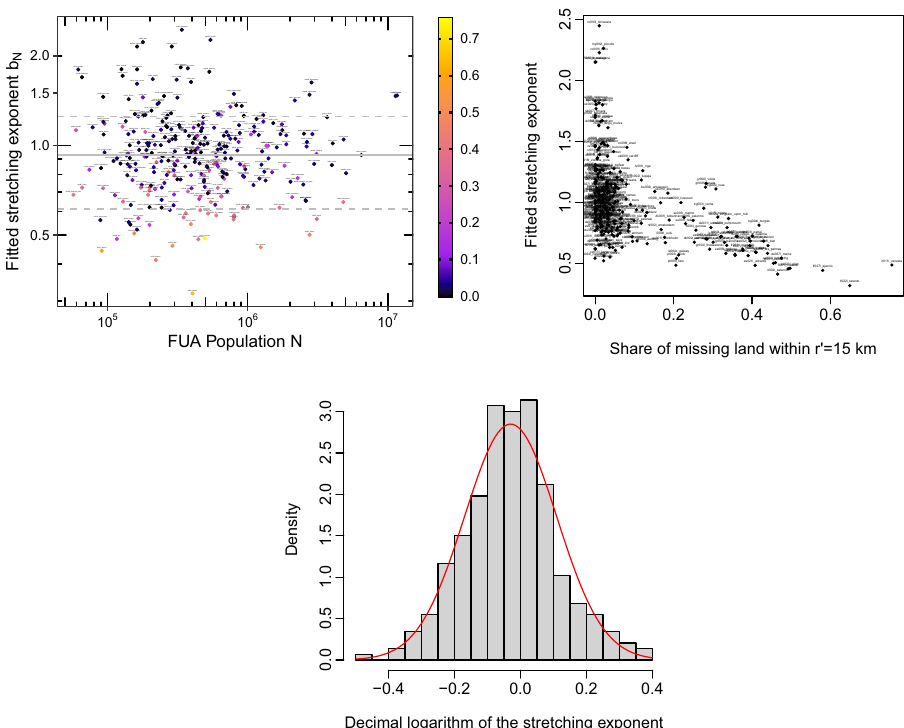
Figure 3. Fitted stretching exponent b , as a function of total population N (top left) and of the share of missing land within a rescaled radius r � = 15 km (top right), indicating that coastal cities tend to have a lower value of b . The bottom panel shows the probability density of the decimal logarithm of this stretching exponent log 10 ( b ) (black rectangles), compared with the pdf of a normal distribution of the same mean − 0.03 and standard deviation 𝜎 = 0.14 (red line), used as a guide to the